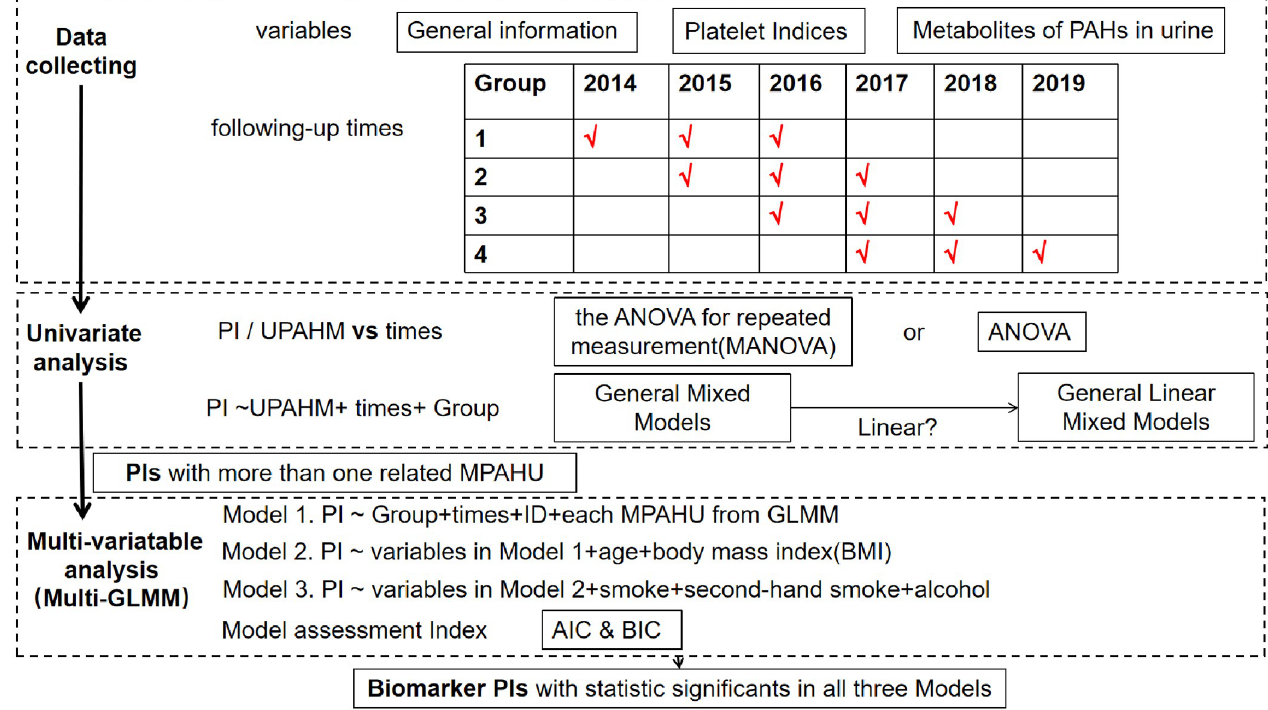
Fig 2. The statistical analysis process in the correlation